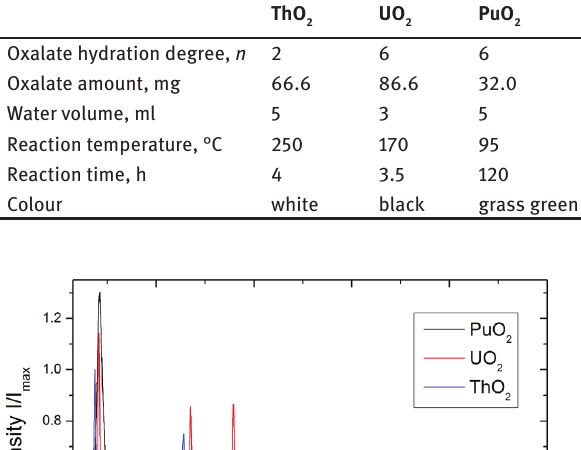
Figure 1: XRD patterns of the nanocrystalline An O hydrothermal decomposition of the corresponding oxalates; a comparison between ThO